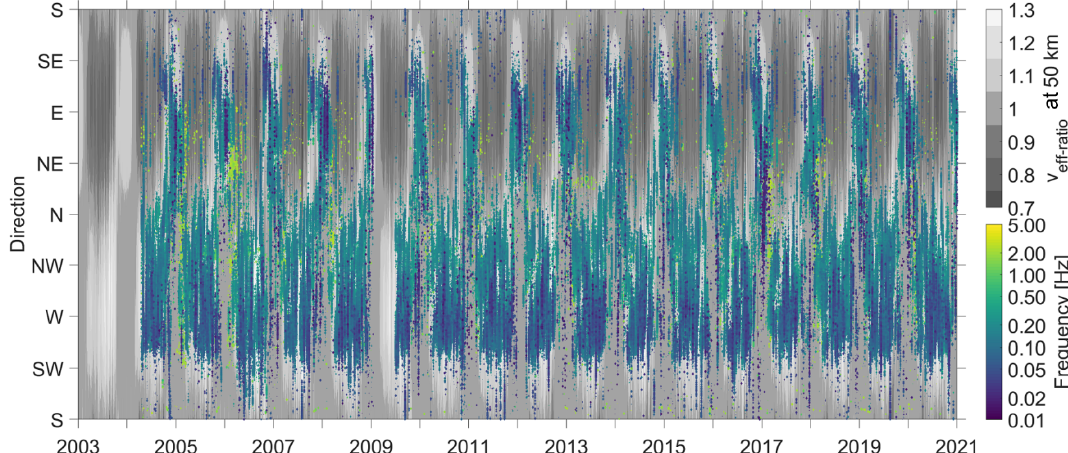
Figure 4. Detections at IS27 from 2004 to 2020, with color-coded frequency. The lack of detections in 2009 is because of the array’s relocation and revalidation (see Sect. 2.1). The v eff-ratio at around 50km altitude (grayscale) was calculated from temperature and wind profiles obtained from ECMWF’s HRES operational atmospheric model analysis as the maximum ratio between 40 and 60km. Dark gray background colors ( v eff-ratio < 0 . 95) indicate unfavorable propagation from the respective direction, whereas favorable conditions in light gray ( v eff-ratio ≥ 0 . 95) often coincide with an increased number of detections. The majority of detections are microbaroms (0.1–0.5Hz) originating from the Antarctic Circumpolar Current (northwesterly to northeasterly